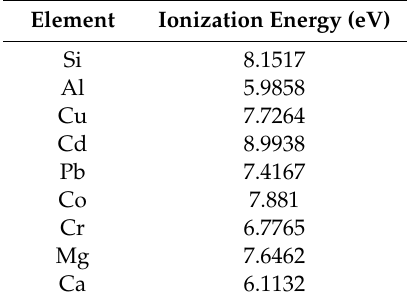
Table 2. Specific parameters of used